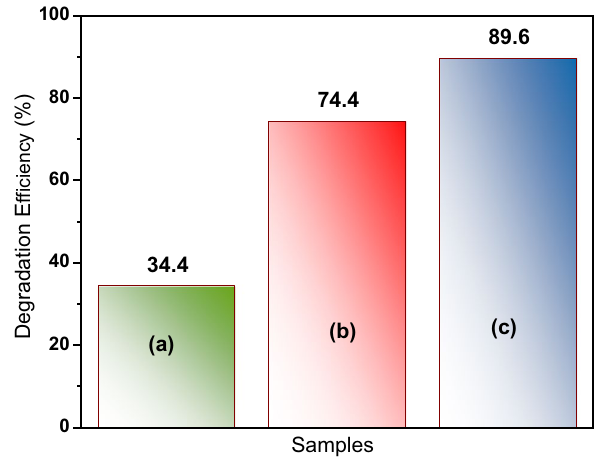
Fig. 9 Degradation efficiency of MO (a) SnO NPs and (c) 4% Zr-doped SnO 2 NPs